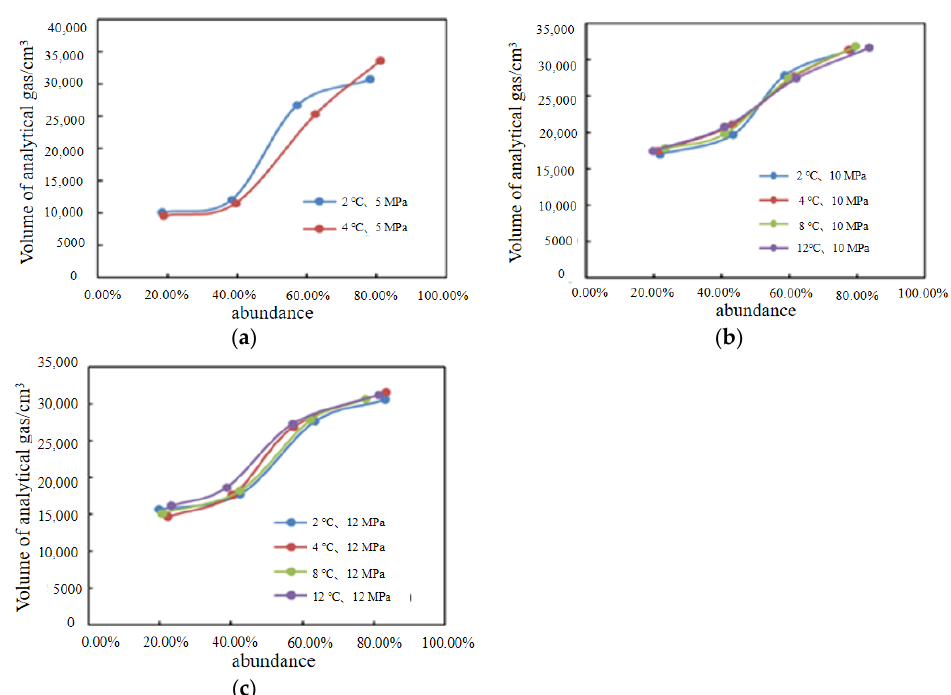
Figure 5. Relationship between analytical gas and abundance of hydrates ( a ) The test pressure is 5 MPa; ( b ) The test pressure is 10 MPa; ( c ) The test pressure is 12 MPa.